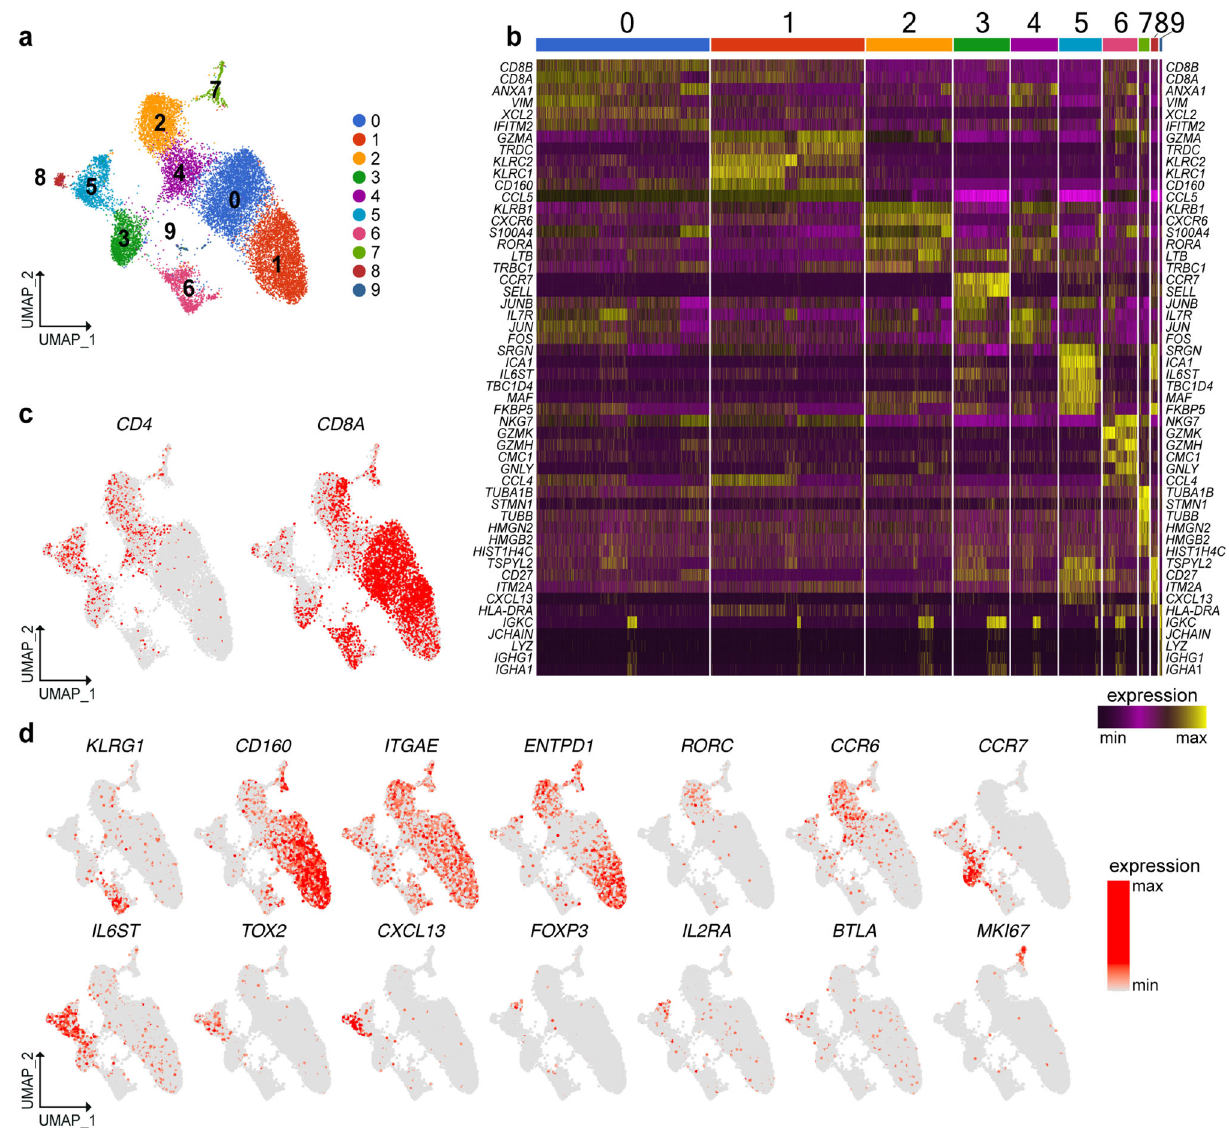
Fig. 1 scRNA-seq of IEL T cells identi fi es discrete subsets of CD4 + and CD8 + T cells. a Unsupervised UMAP analysis of IEL T cell clusters. T cells were pooled from two controls and two CD patients (8822 cells control, 6909 cells CD). b Heat map displaying the top ten differentially expressed genes in each cell cluster. c Identi fi cation of CD4 and CD8A expressing cells. d UMAP of representative selected genes associated with the identi fi ed